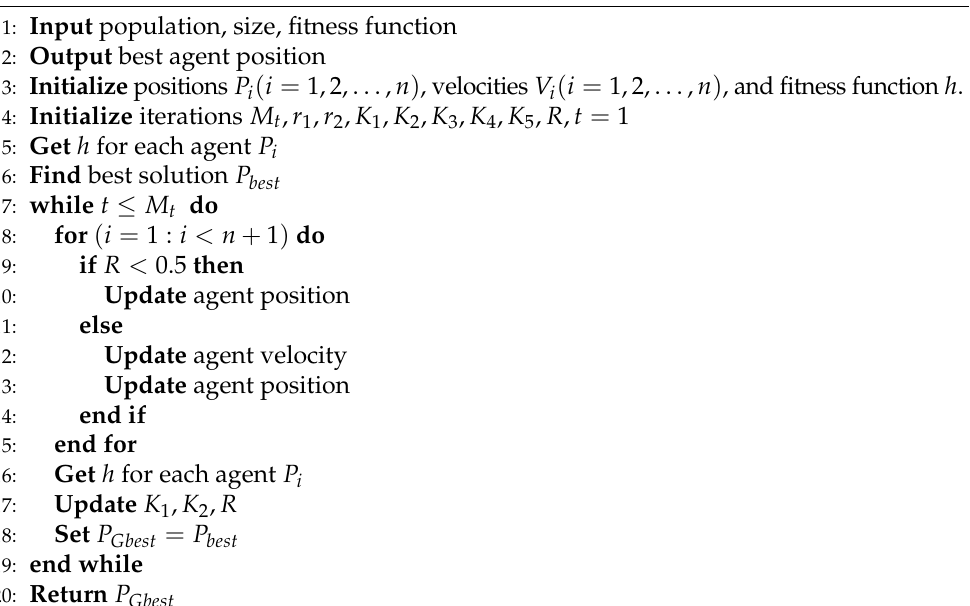
Algorithm 1 The Dipper Throated Optimization